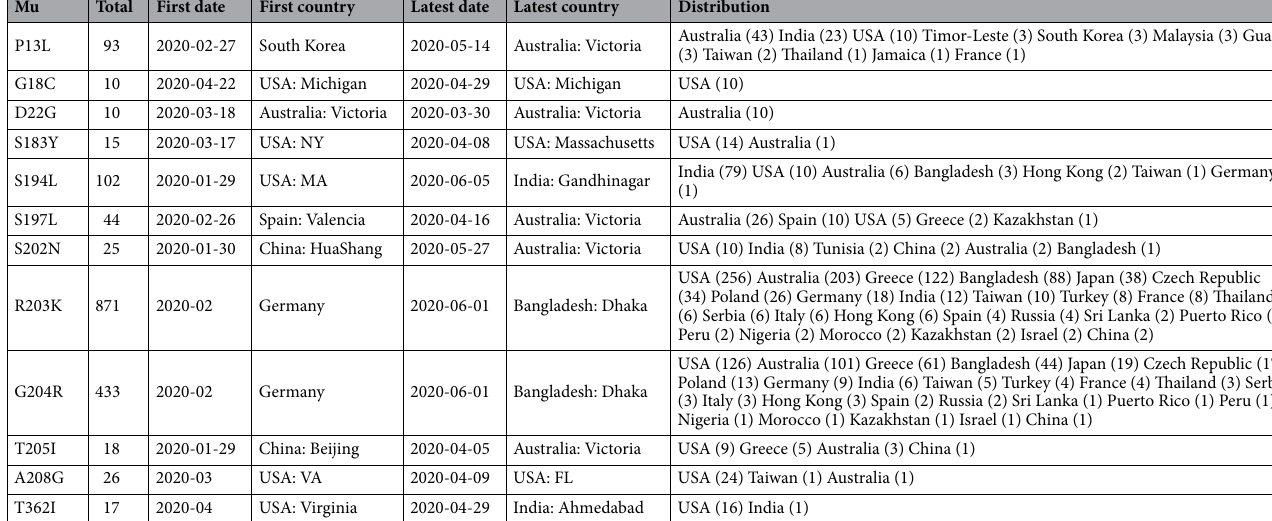
Table 15. Gene N—nonsynonymous mutations occurring in 10 or more